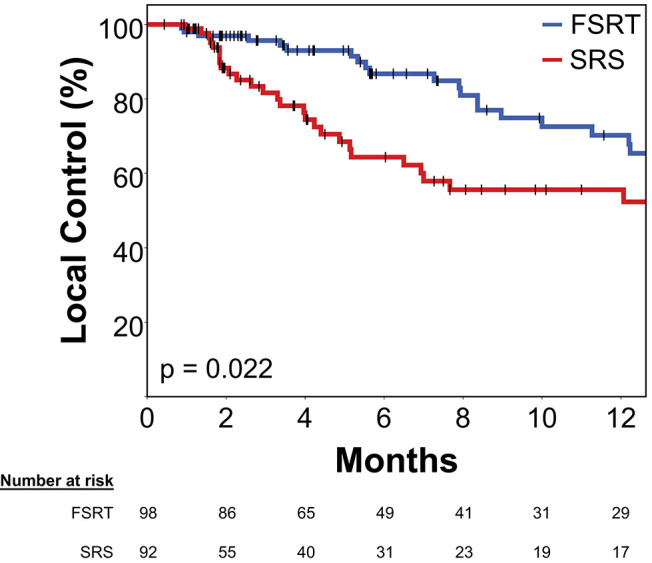
Local control in 92 brain metastases treated with SRS (red) and 98 brain metastases treated with FSRT (blue). Log-rank p = 0.022. Progression was defined volumetrically or as tissue diagnosis showing viable tumor after radiotherapy (see Methods section for details). Vertical lines represent censored cases. SRS, Stereotactic radiosurgery; FSRT, Fractionated stereotactic radiotherapy.